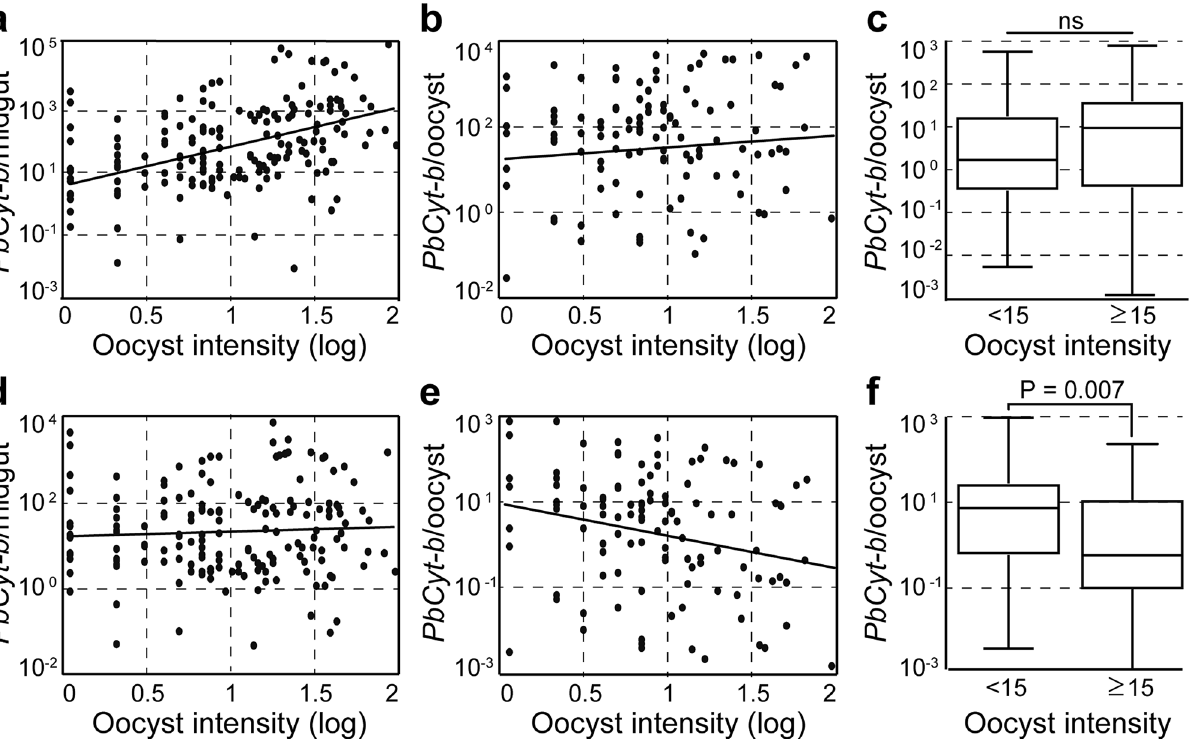
Figure 1. P. berghei Cyt-b DNA abundance is oocyst density dependent. ( a ) Correlation between oocyst density (log) and abundance of PbCyt-b mitochondrial DNA 7 dpi (r = 0.24; P < 0.0001). ( b ) Correlation between oocyst density (log) and PbCyt-b DNA abundance PCO 7 dpi. ( c ) PbCyt-b DNA abundance PCO in low and high oocyst density midguts 7 dpi. ( d ) Relationship between oocyst intensity (log) and PbCyt-b DNA abundance 14 dpi. ( e ) Correlation between oocyst density (log) and PbCyt-b DNA abundance PCO 14 dpi (r = -0.25; P = 0.001). ( f ) PbCyt-b DNA abundance PCO in low and high oocyst density midguts 14 dpi. In scatterplots, each dot represents a single midgut and lines show linear regression fit. Horizontal lines in boxplots indicate median. Data were generated from at least two independent